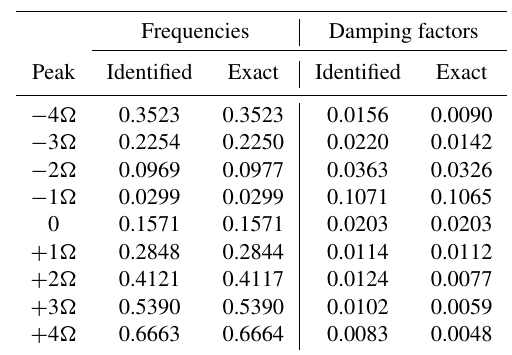
Table 1. Frequencies and damping factors for the Mathieu oscillator and analytical